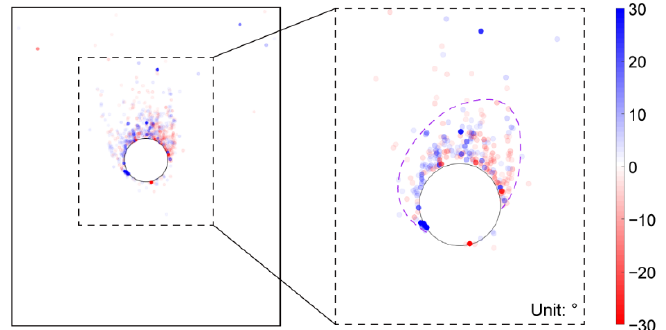
Figure 12. Particle rotation after the tunnel excavation in the basic case of